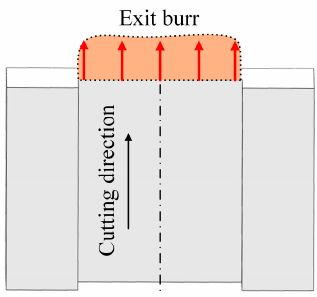
Figure 5. Exit burr growing direction in orthogonal cutting.